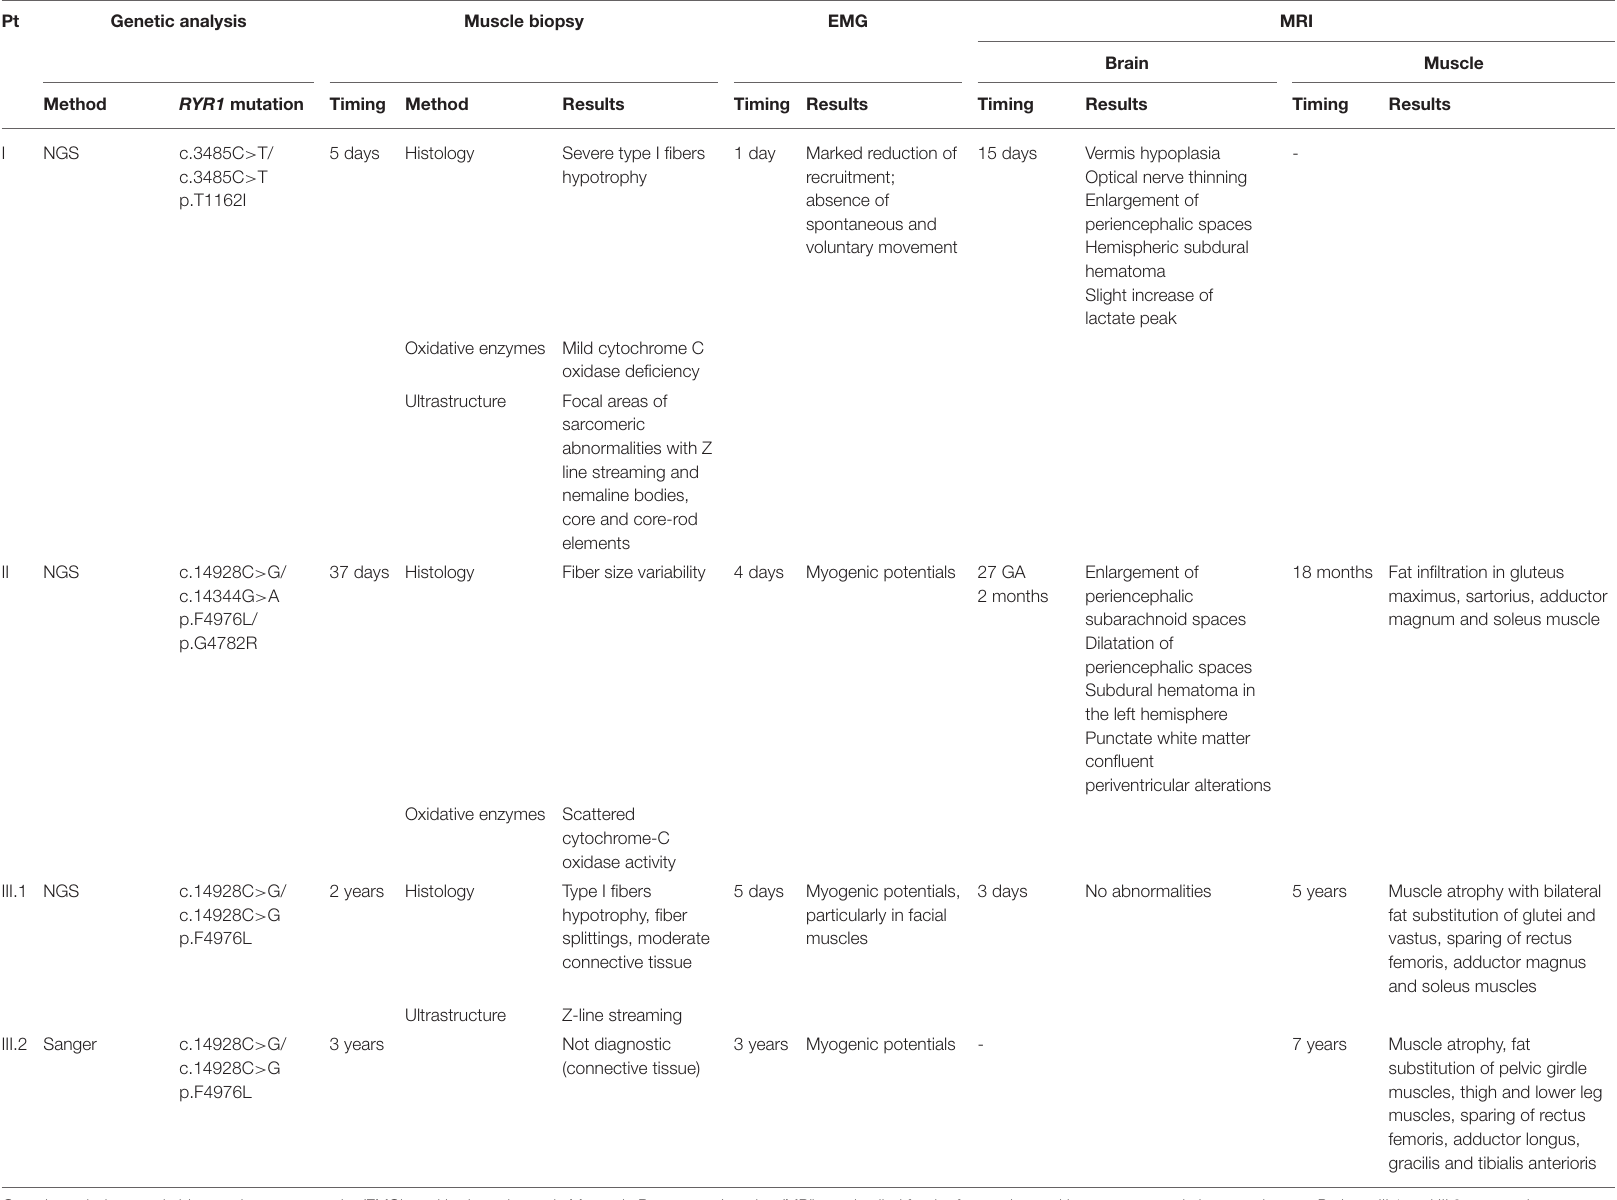
TABLE 1 | Instrumental assessment in severe congenital neonatal RYR1